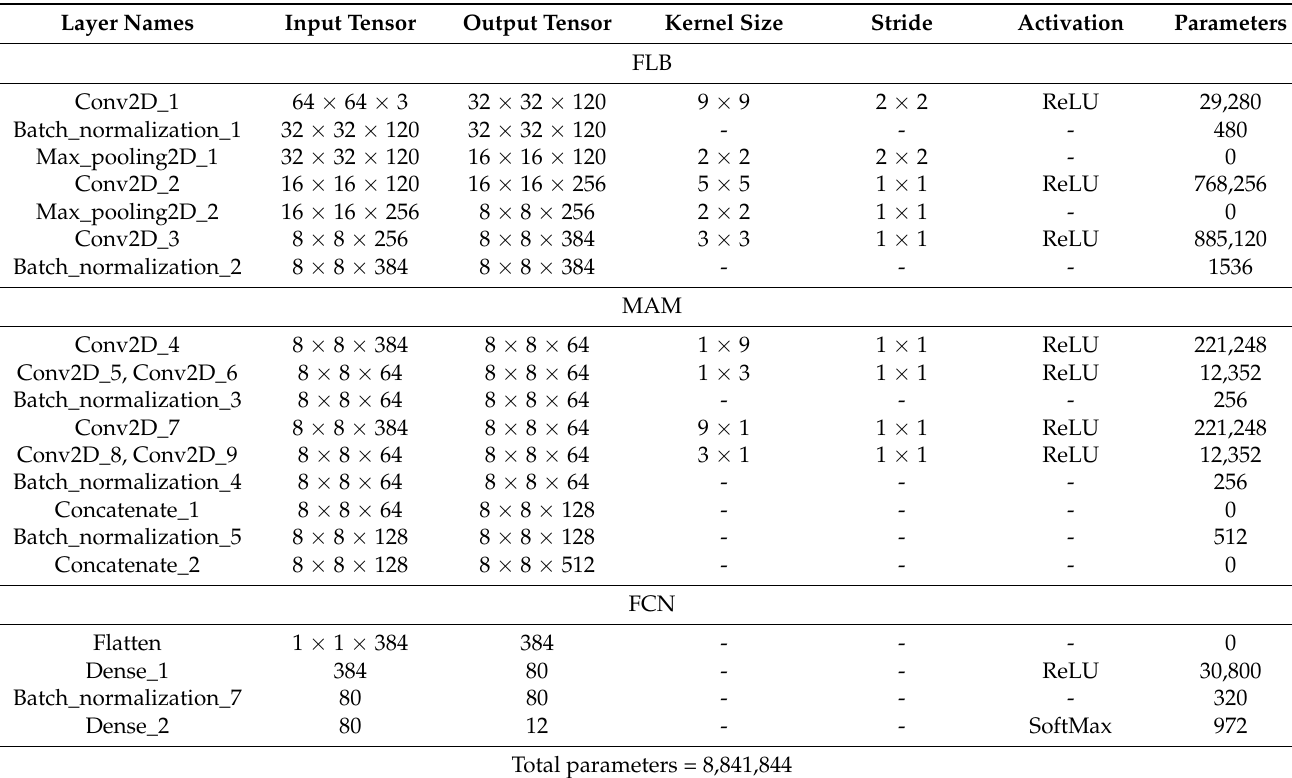
Table 1. Detailed configuration specifications of our proposed model, including layer names, input tensor, output tensor, and parameters.